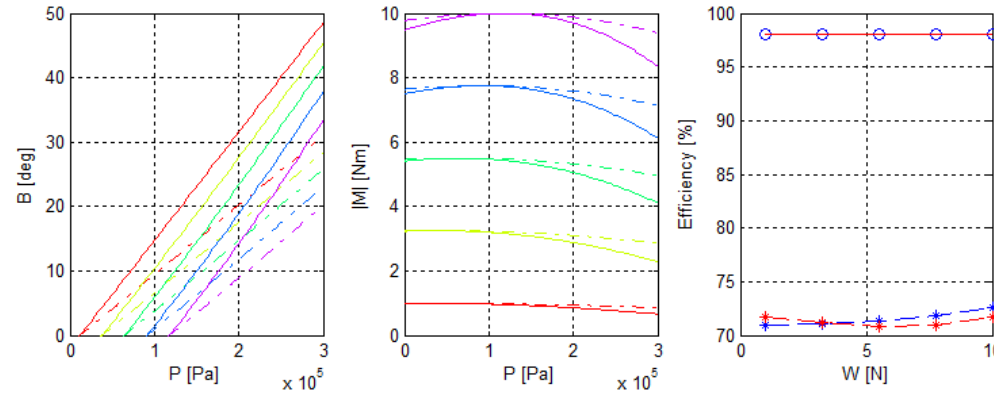
Figure 11. ( Left )—Response Angle of the HELM under different loading weights, W = 1, 2 . . . 10 N marked by red to violet lines, respectively. Solid lines are for natural rubber and dashed lines for nitrile rubber. ( Center )—Bending moment at base, for each corresponding case. ( Right )—actuation efficiency vs. weight load, for nitrile (dashed line) and natural (solid line) rubber. Red marks a pressure range of 1.5–3 Bar and blue 0–3 Bar.